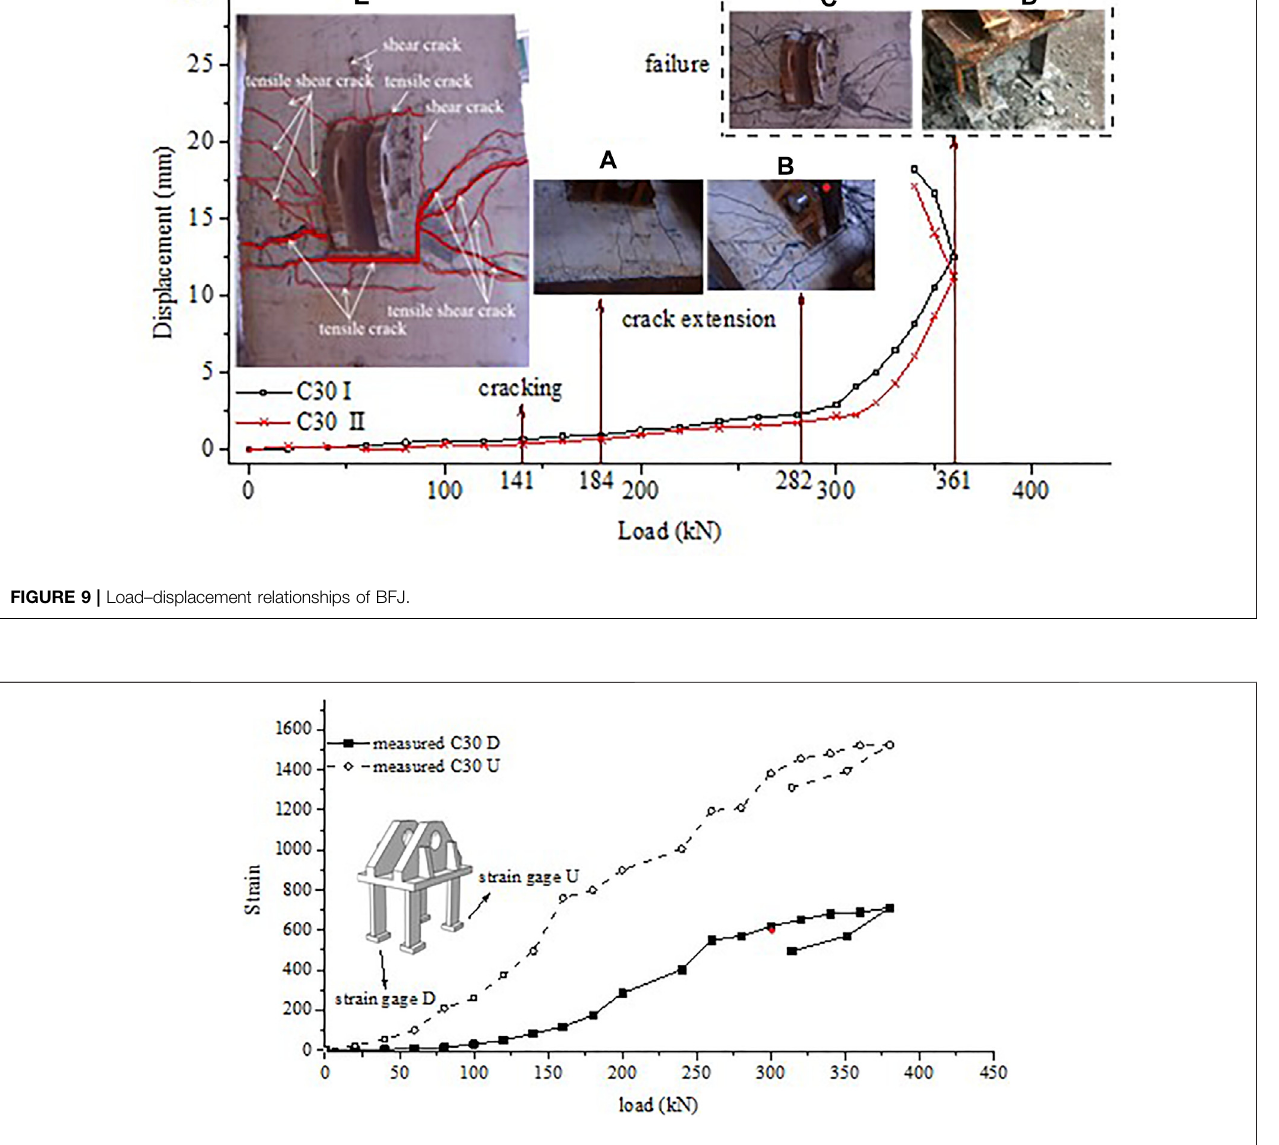
FIGURE 10 | Load – strain relationships of PESC.